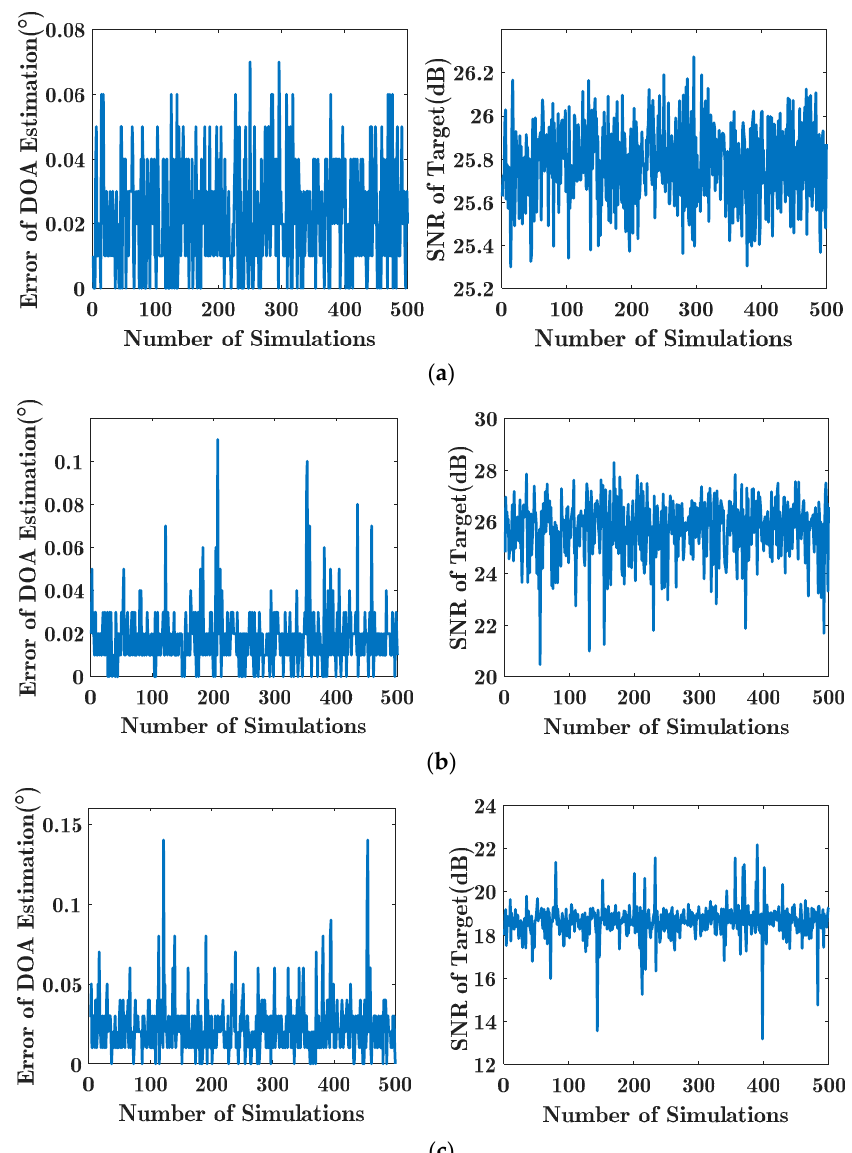
Figure 14. DOA estimation of the target in different numbers of jammers: ( a ) one mainlobe jammer; ( b ) two mainlobe jammers; ( c ) three mainlobe jammers.